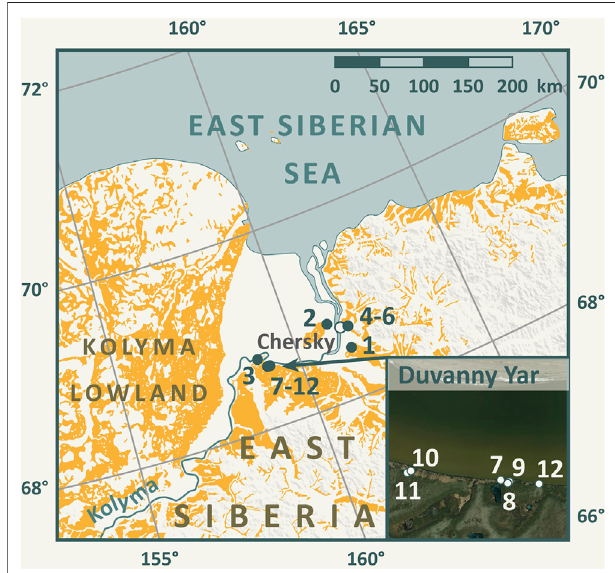
FIGURE1| Locationofthestudysites.Theyellowishbackgroundispart of the Yedoma map (Strauss et al., 2021), where ice rich Yedoma occurrence is likely. Numbers show the locations of (1) Malchikovskaya channel, (2) Lake Akhmelo, (3) Mouth of the Omolon River, (4 – 6) Mount Rodinka and (7 – 12)theDuvannyYarexposure.7 – 12areshownasacloseupintheinseton the lower